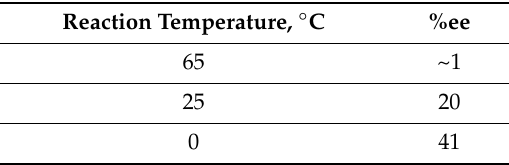
Table 2. Enantioselectivity versus temperature for the bis(amino acid)palladium(II) catalyzed oxidative coupling of phenylboronic acid to methyl tiglate.